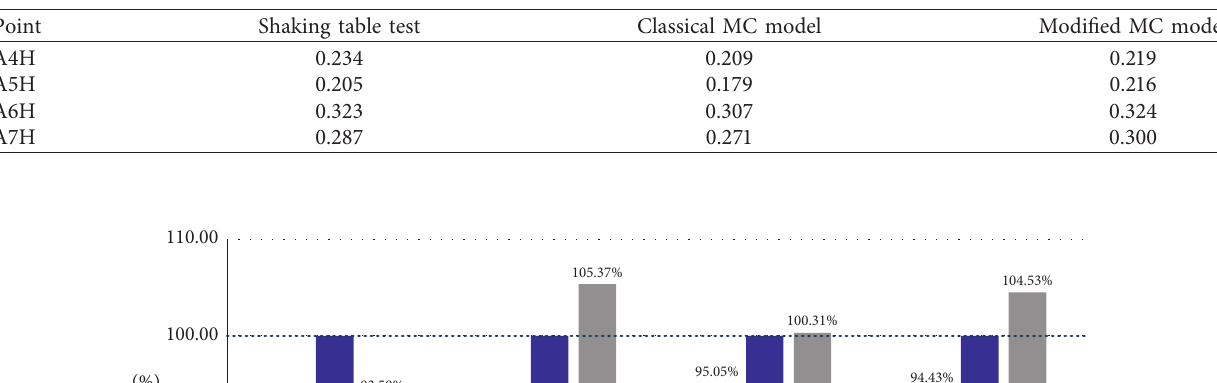
Figure 24: Displacement time history at point A7H. Table 9: Maximum displacements at the monitoring points for the different yield criterion models (unit: m).